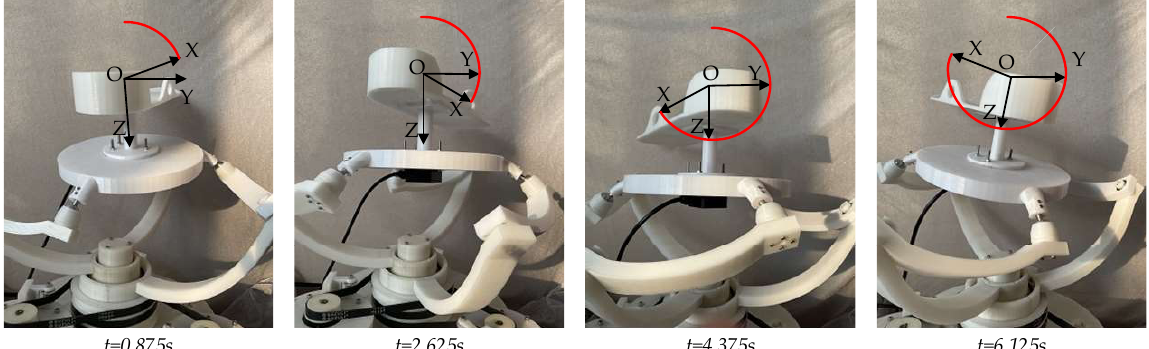
Figure 13. Prototype experiment track.